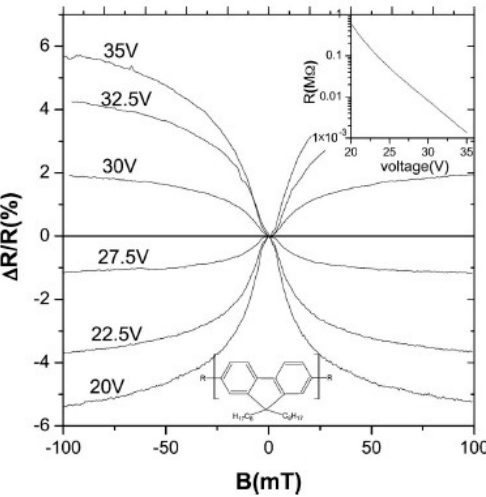
Figure 10. MR versus magnetic field in ITO/PFO ( ≈ 60 nm)/Ca devices. The inset shows the variation of device resistance with voltage by Mermer et al. [11] with the permission of Physical Review B.